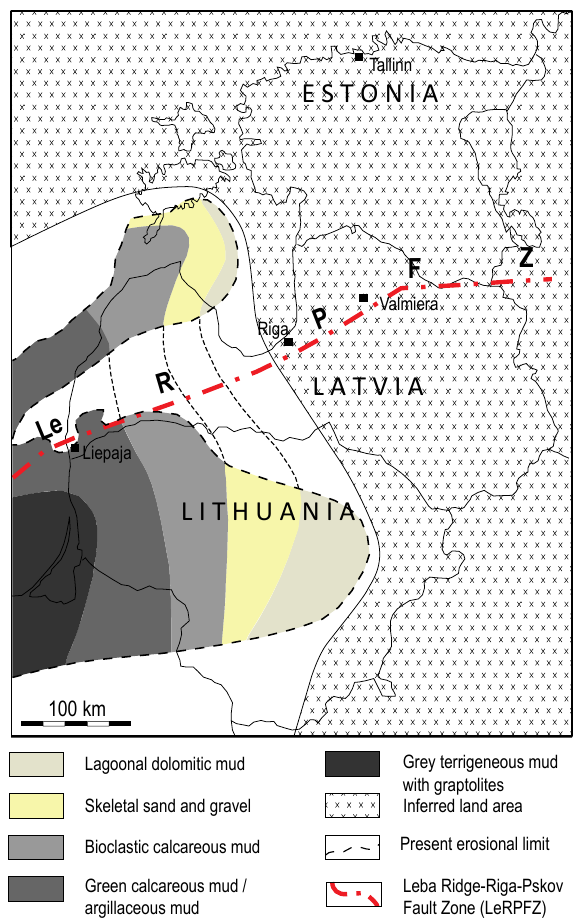
Fig. 7. The facies distribution of the Baltic Basin with the Livonian Tongue around the LeRPFZ in earliest Přidoli (Kaugatuma) time (modified after Nestor & Einasto